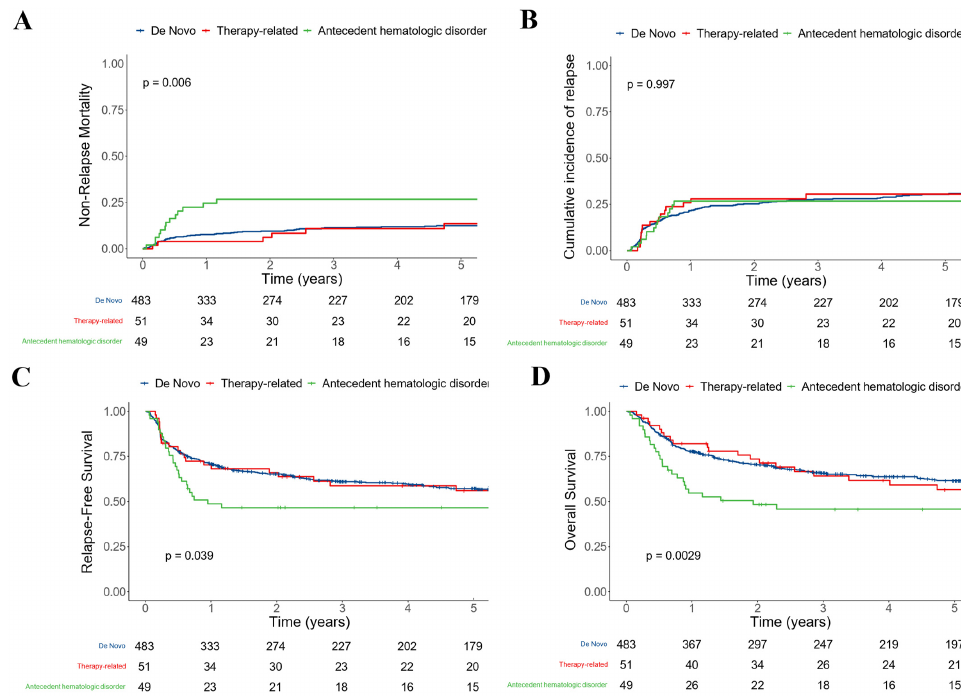
Figure 2. Post-HCT outcomes for 583 adults with AML undergoing allogeneic HCT following myeloablative conditioning while in first or second morphologic remission, stratified by disease status at diagnosis (de novo vs. therapy-related vs. antecedent hematologic disorder): ( A ) Non-relapse mortality; ( B ) relapse; ( C ) relapse-free survival; and ( D ) overall survival.